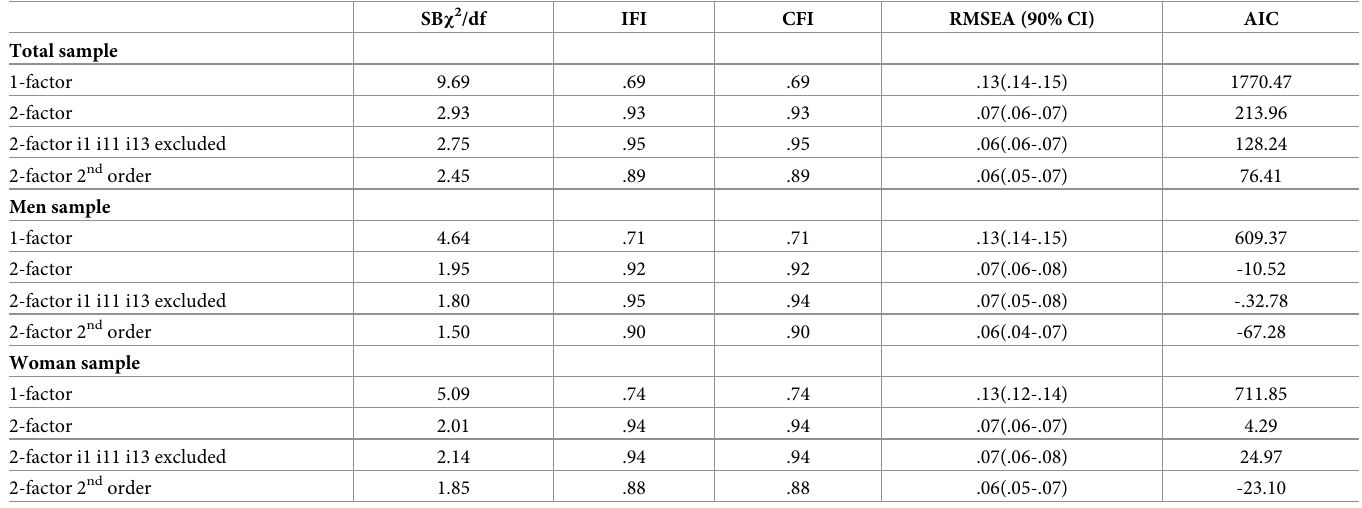
Table 1. Model fits of the